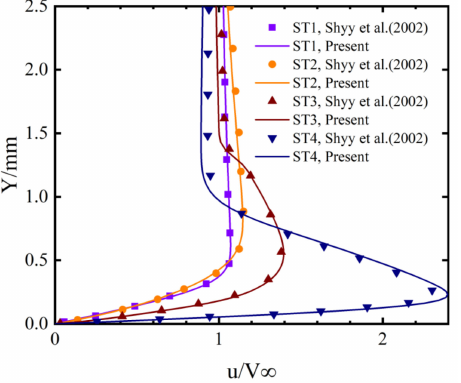
Figure 4. Velocity profiles at four different locations.